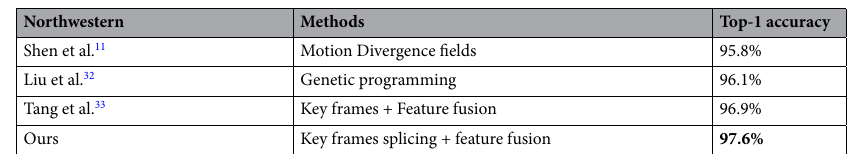
Table 3. Compares our method with state-of-the-art methods on the Northwestern University Hand Gesture datasets. Significant values are in bold.